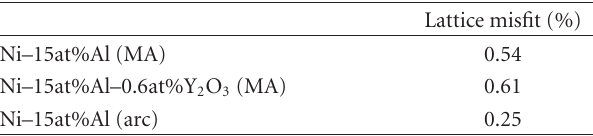
Table 2: Lattice misfit parameters at 800 ◦ C measured by X-ray di ff